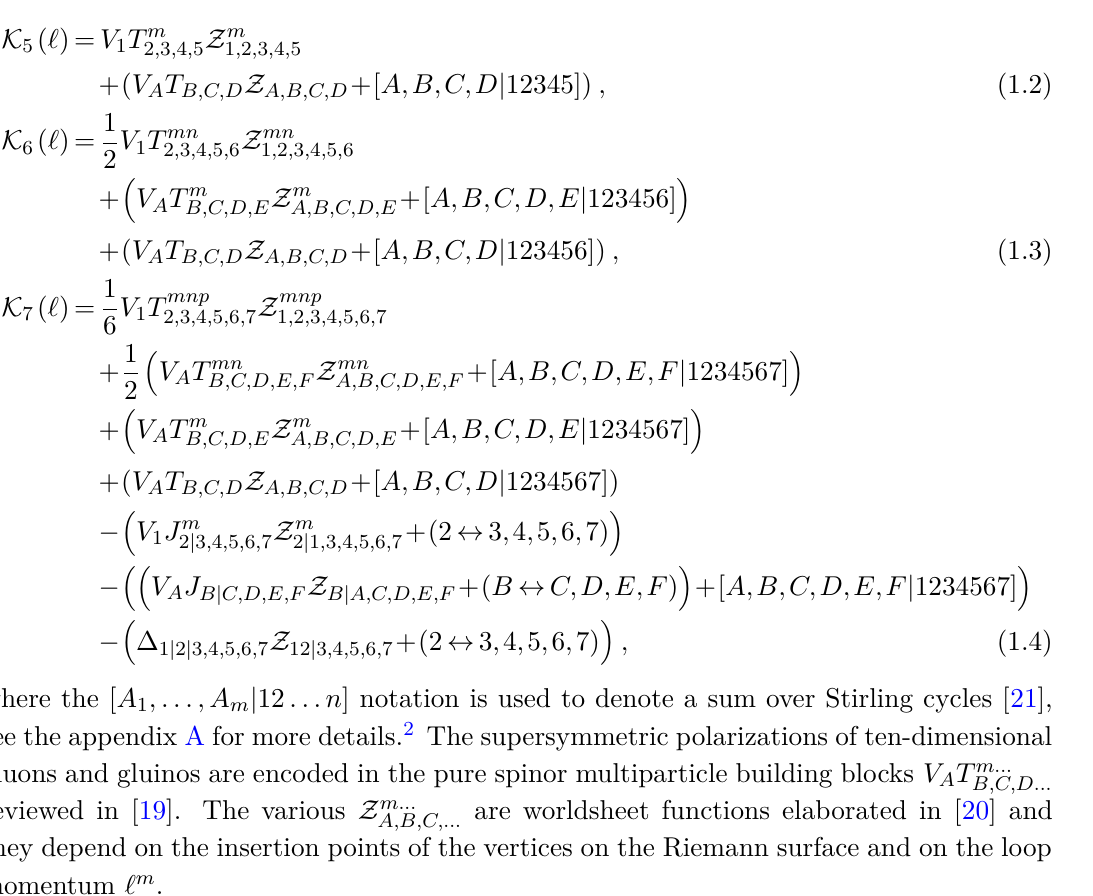
Figure 1 . The multiparticle superfields and pure spinor one-loop building blocks lead to intuitive mappings between one-loop cubic graphs and pure spinor superspace expressions encoding the polarization dependence of ten-dimensional supersymmetric Yang-Mills states